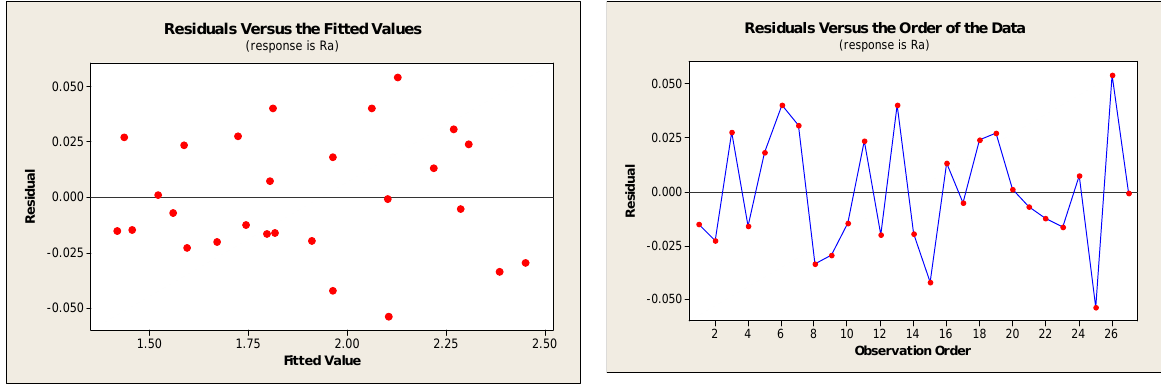
Fig. 5. Residuals vs. fitted value for Ra Fig. 6. Residuals vs. order of the data for Ra